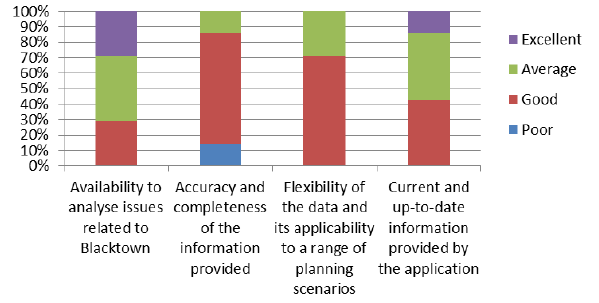
Figure 8. Performance rating of PSS measures in the Blacktown study